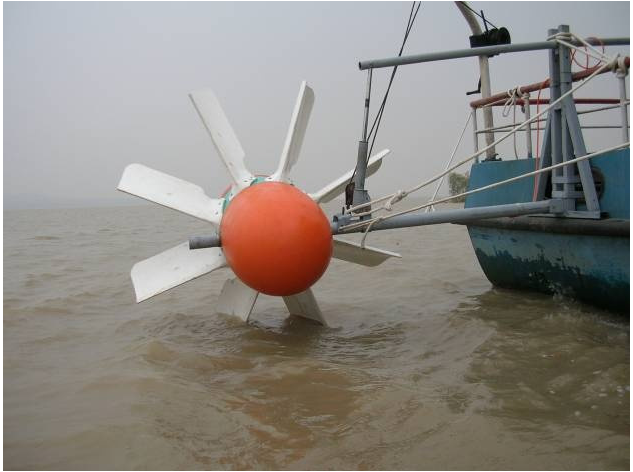
Figure 9. A 1 kW floating horizontal-axis low-speed direct-drive TCPGS. Reproduced from [33].